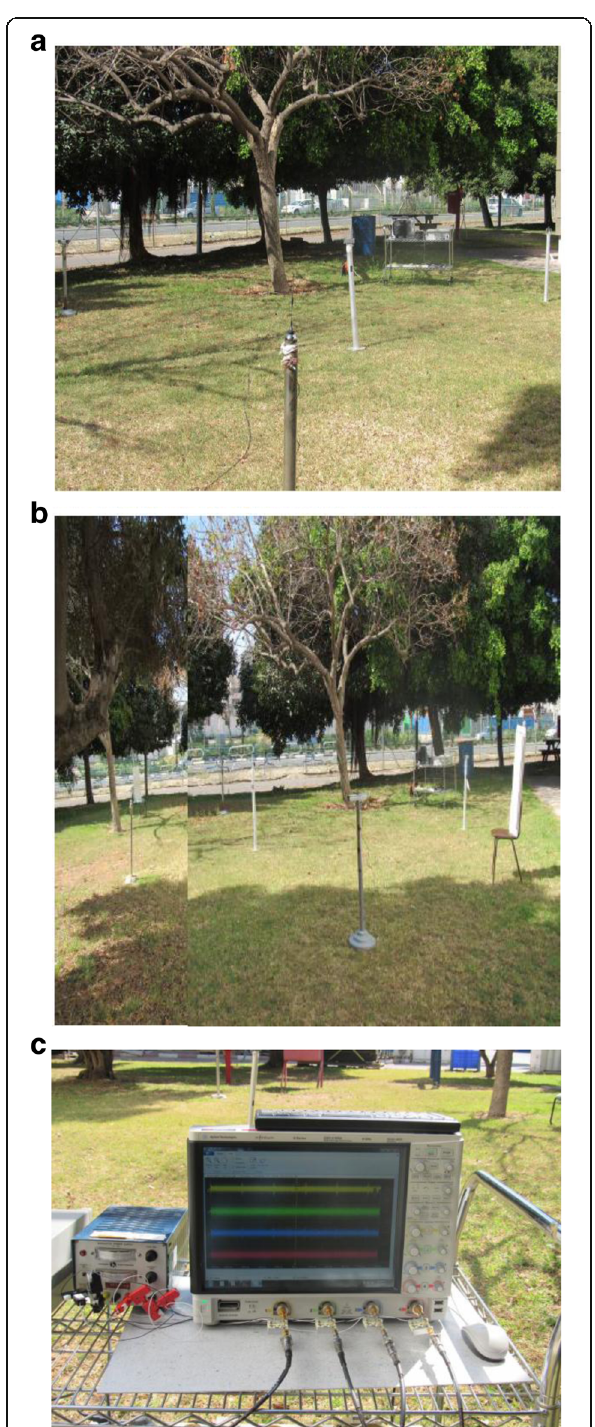
Fig. 9 Outdoor ( a ) setup without reflectors; ( b ) setup with reflectors; ( c ) measurements with the digitizer receiver